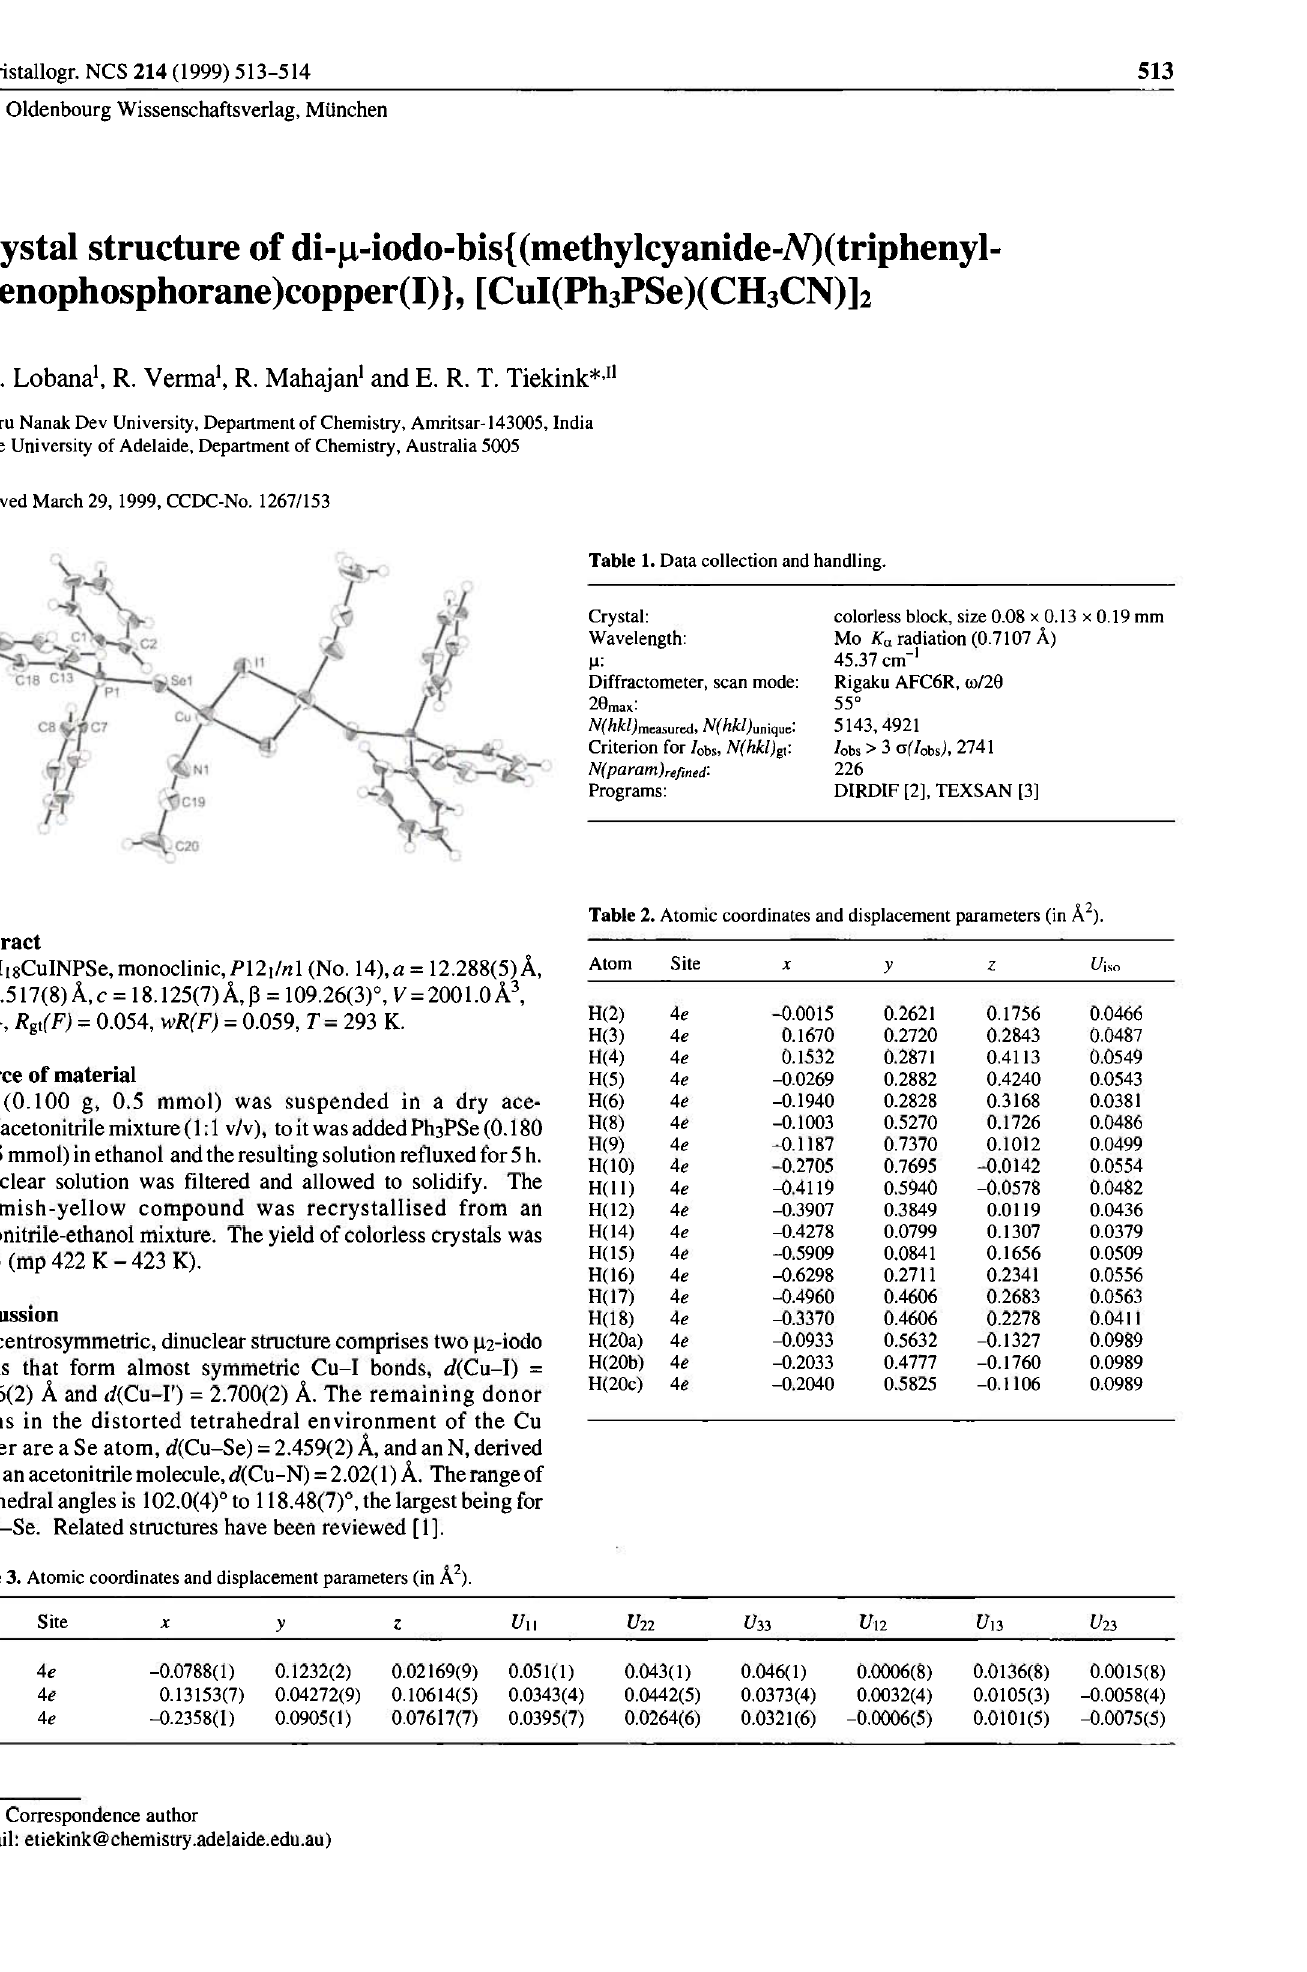
Table 1. Data collection and handling.